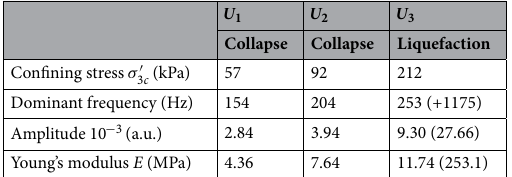
Table 2. Parameters of isotropic collapses U 1 , U 2 and liquefaction U 3 in isotropic compression from 20 to 212 kPa of confining